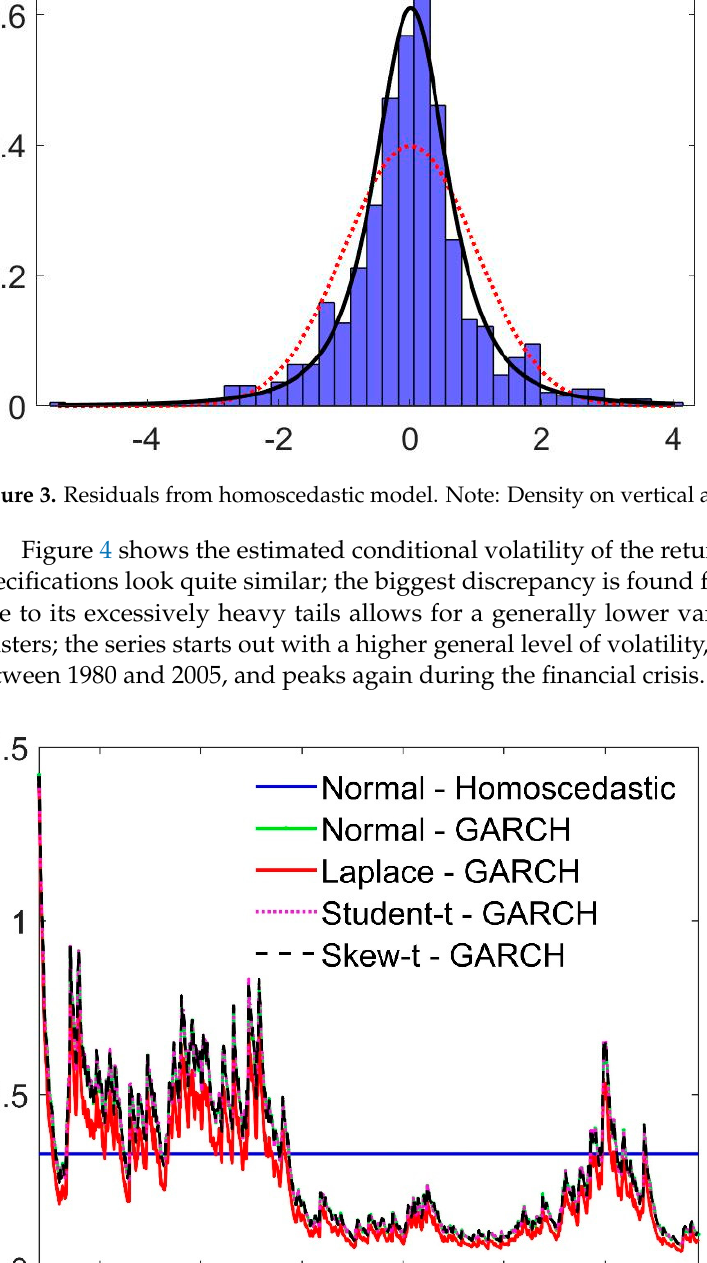
Table 4. Forecast evaluation results.